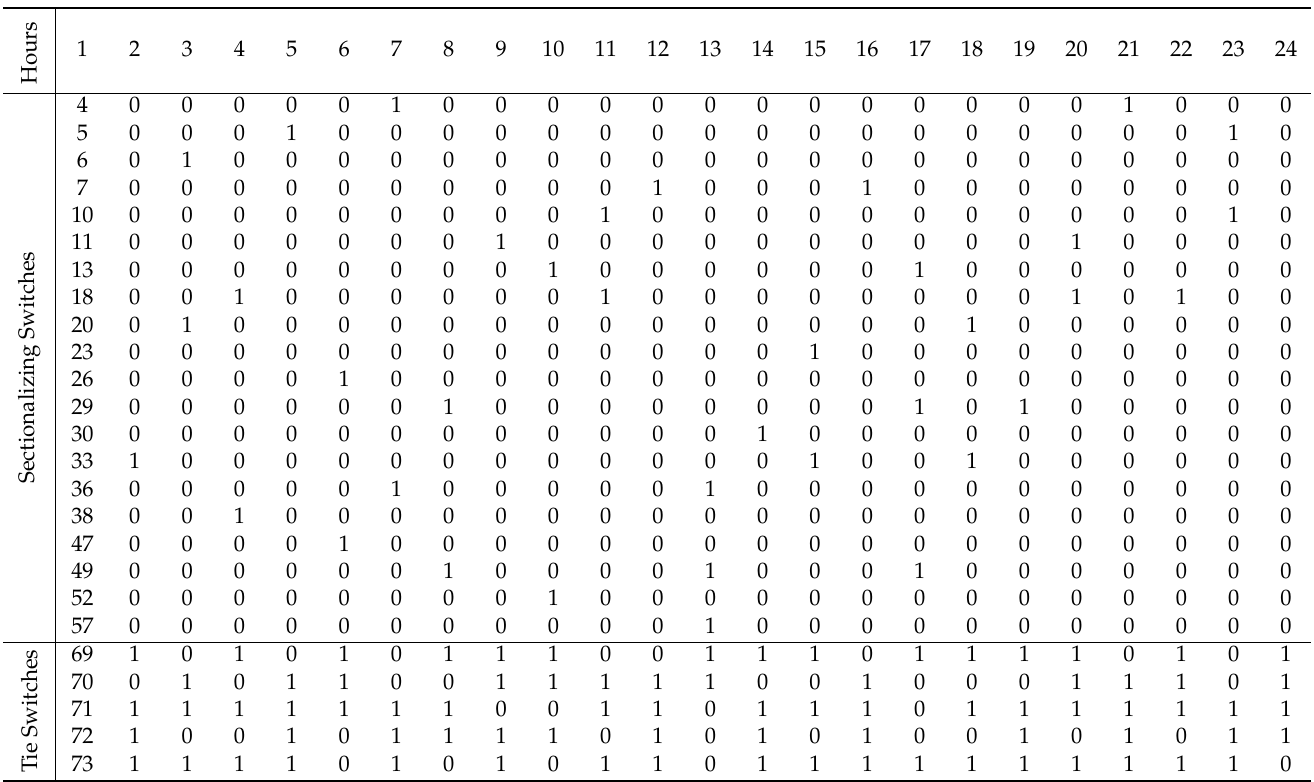
Table 10. Optimal switching pattern in the microgrid.